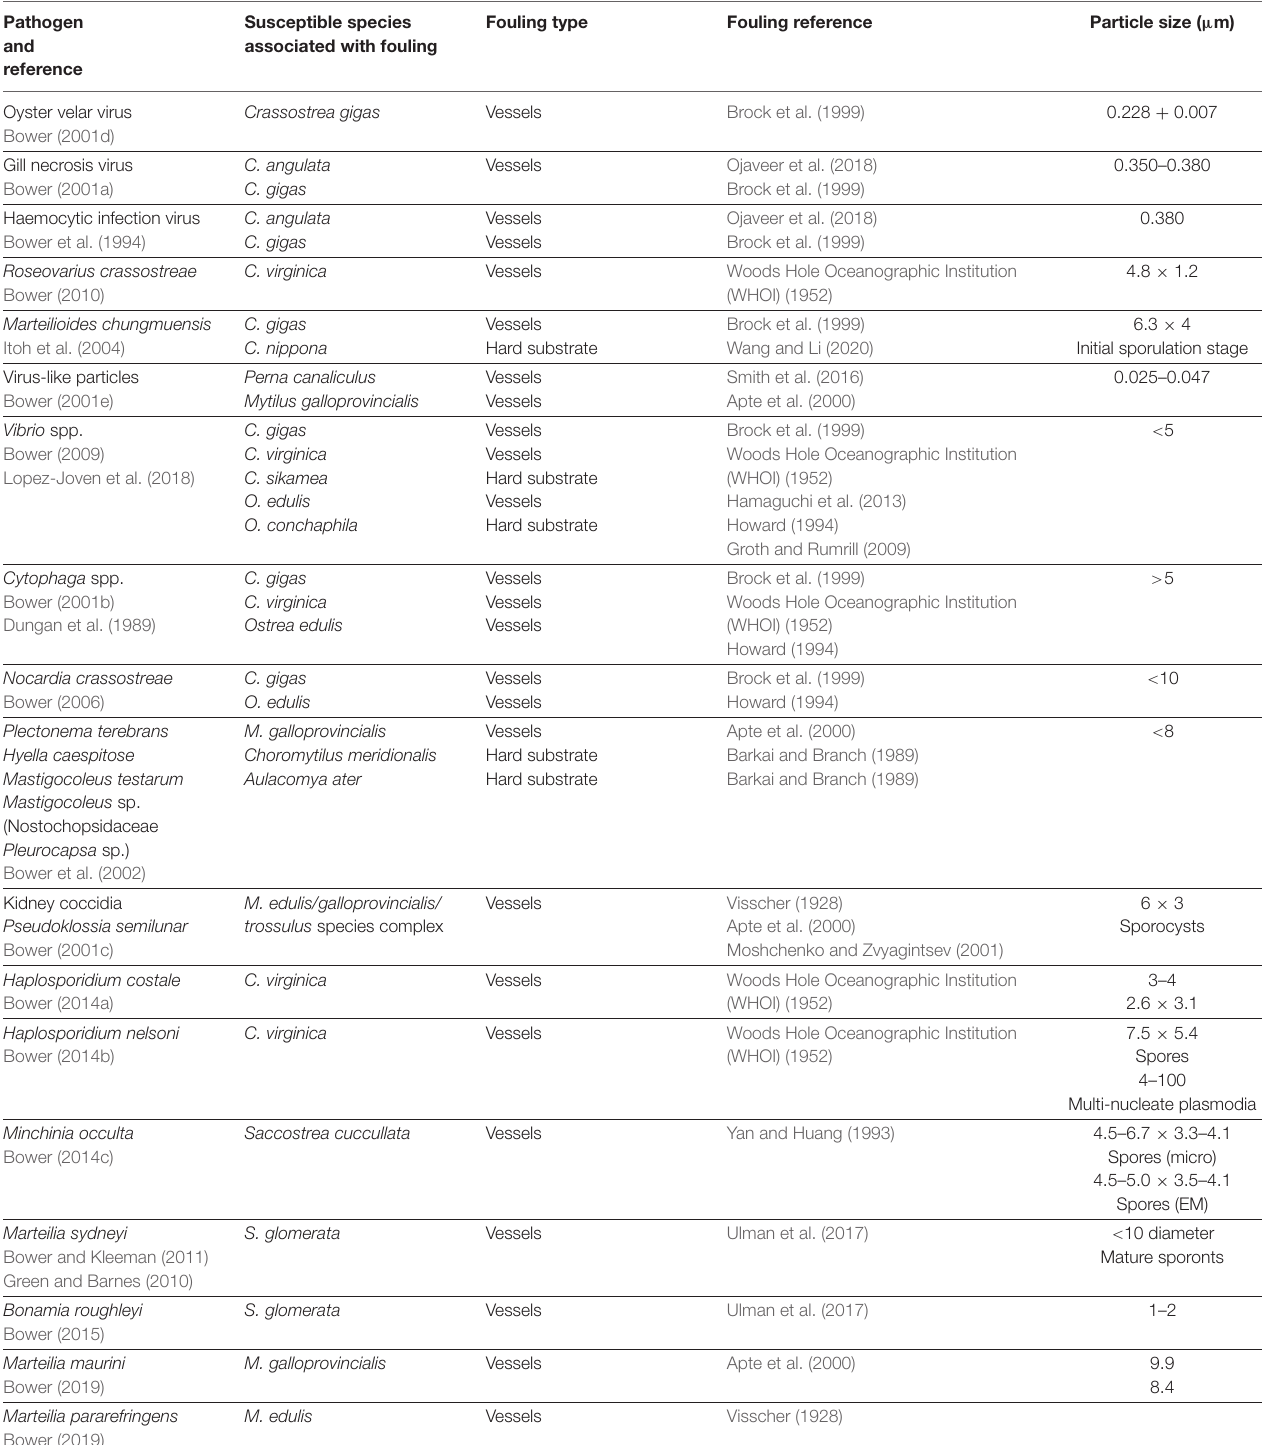
TABLE 2 | Examples of non-OIE listed molluscan pathogens that have caused substantial impacts and are associated with known fouling species (per Bower,